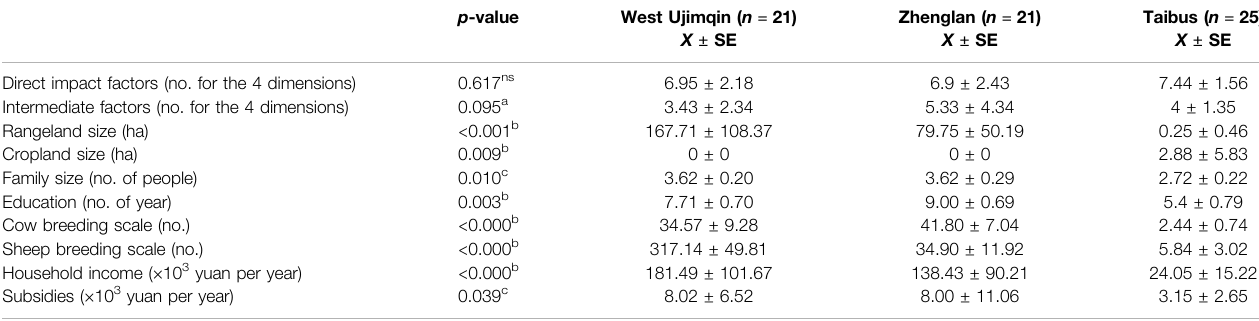
TABLE 1 | Overview results of fuzzy cognitive map (FCM) indices, the number of factors per category, and additional indicators between typical